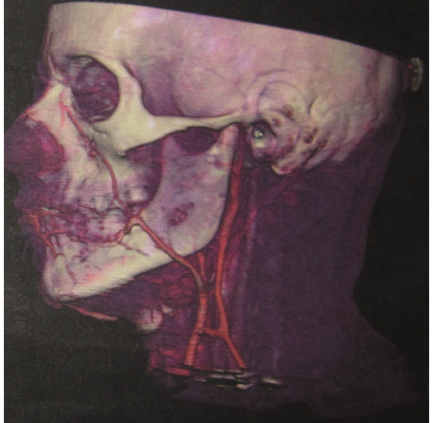
Figure 4: Intraoperative transcortical injection.